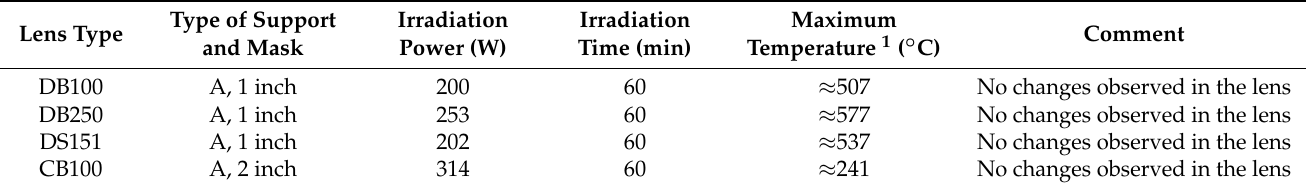
Table 5. Summary of tests performed with concentrated natural